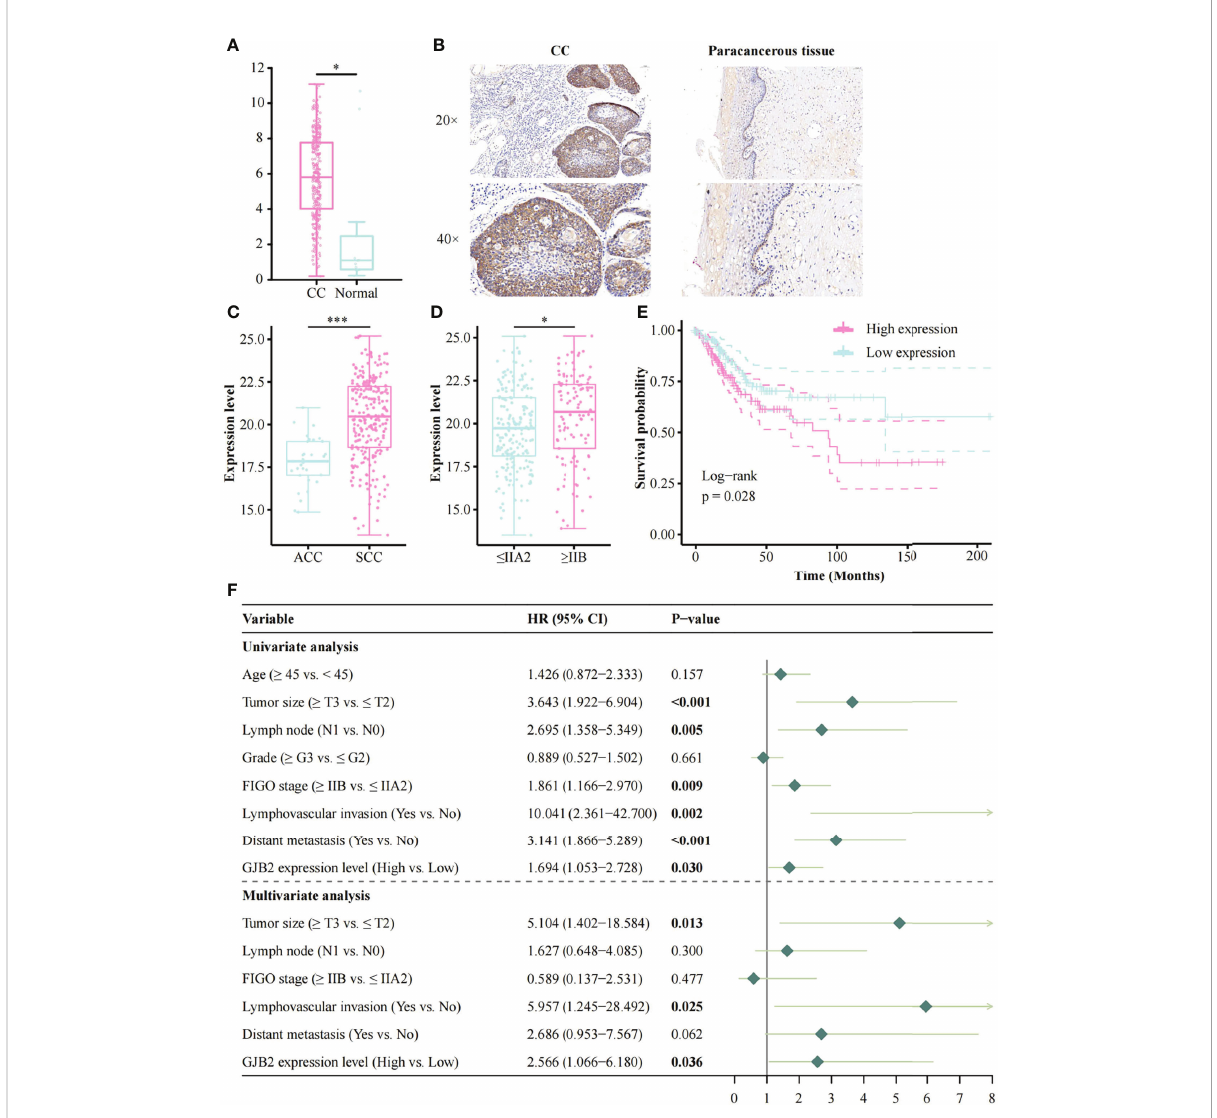
FIGURE 1 The expression of GJB2 and its association with clinical factors and survival analysis based on the TCGA database. (A) The result of GEPIA; (B) GJB2 expression in CC and its paracancerous tissue; (C) Histology; (D) FIGO stage; (E) Impact of GJB2 expression on overall survival in CC; (F) Forest plot for the univariate and multivariate Cox proportional hazard regression model. TCGA, The Cancer Genome Atlas; CC, Cervical cancer; SCC, Squamous cell carcinoma; ACC, Adenocarcinomas; FIGO, The International Federation of Gynecology and Obstetrics; HR, Hazard ratio. *p < 0.05, ***p <